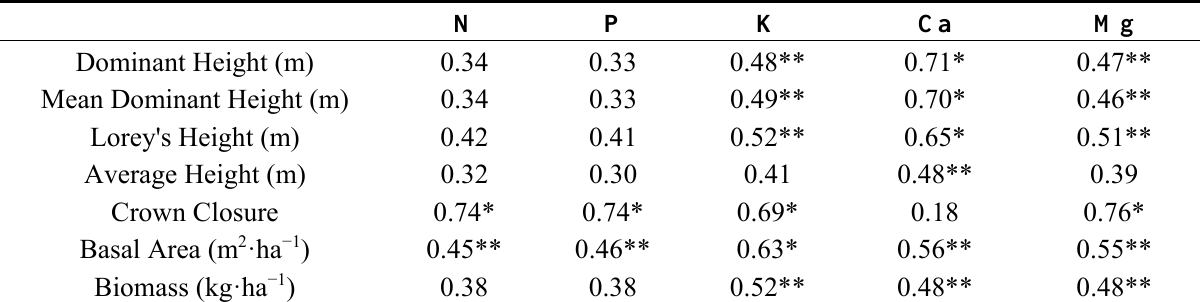
Table 1. Spearman’s correlation coefficients between macronutrient concentration and canopy structural metrics. Units of concentration are %. (* and ** denote significance at p < 0.01 and p < 0.0001, respectively).